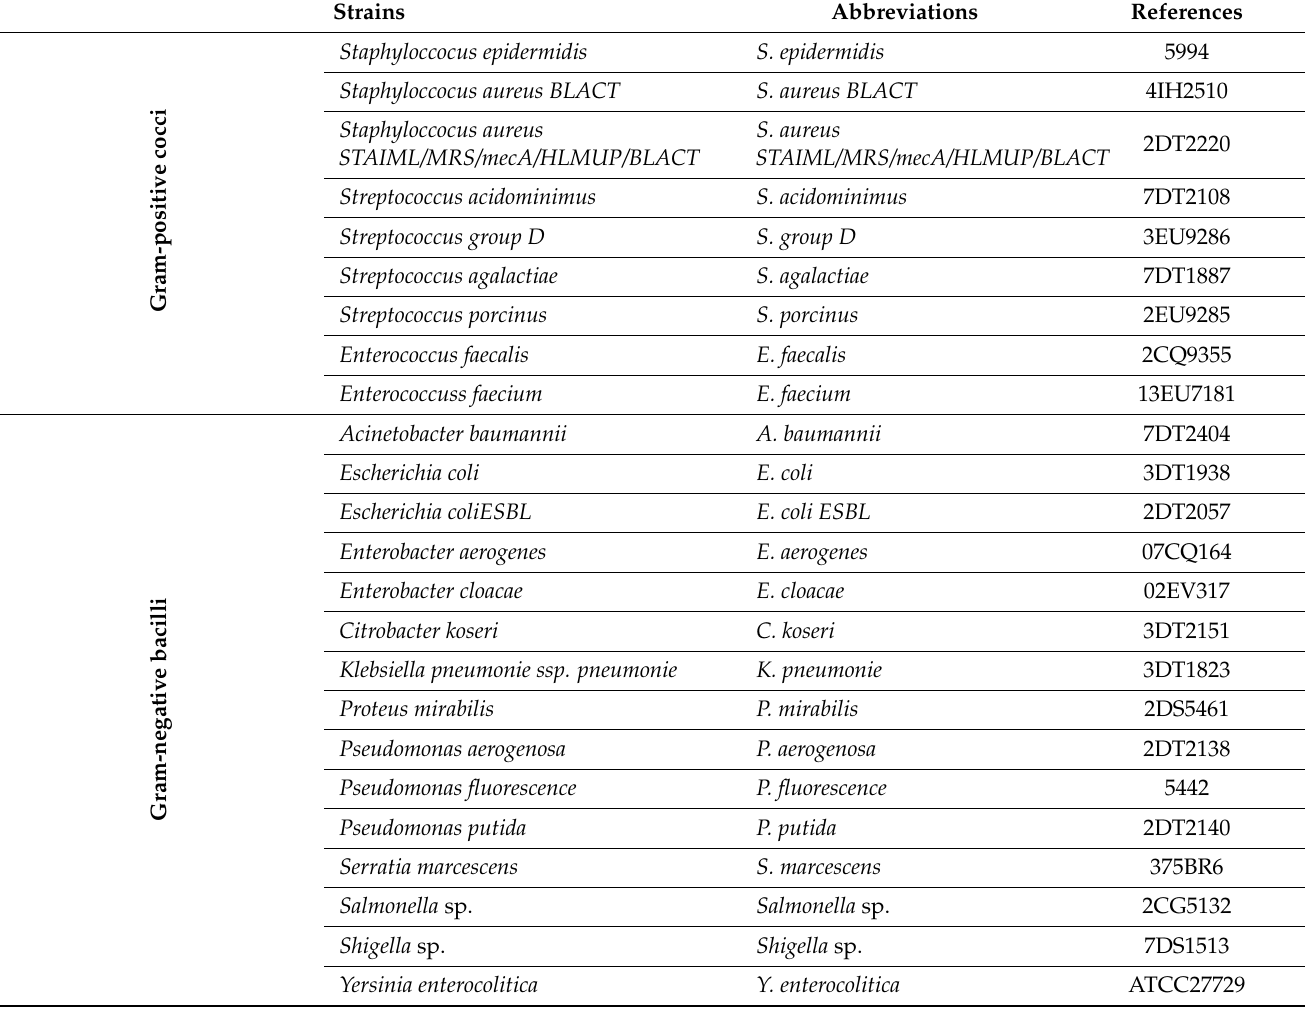
Table 8. List of bacterial and fungal strains tested with their references.